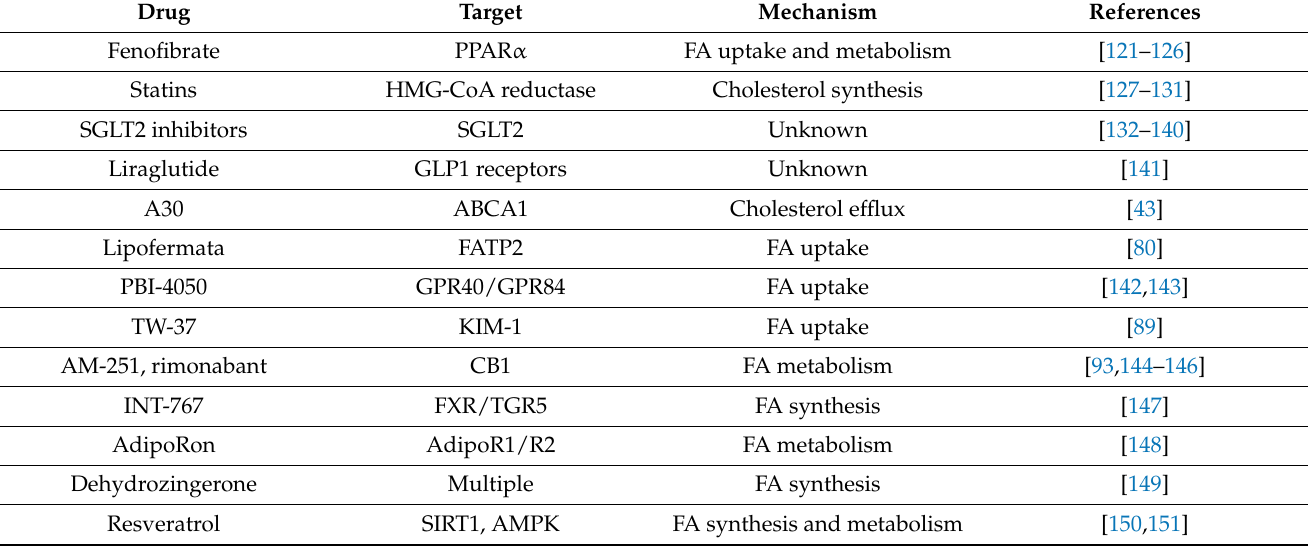
Table 1. Candidate drugs for the treatment of renal